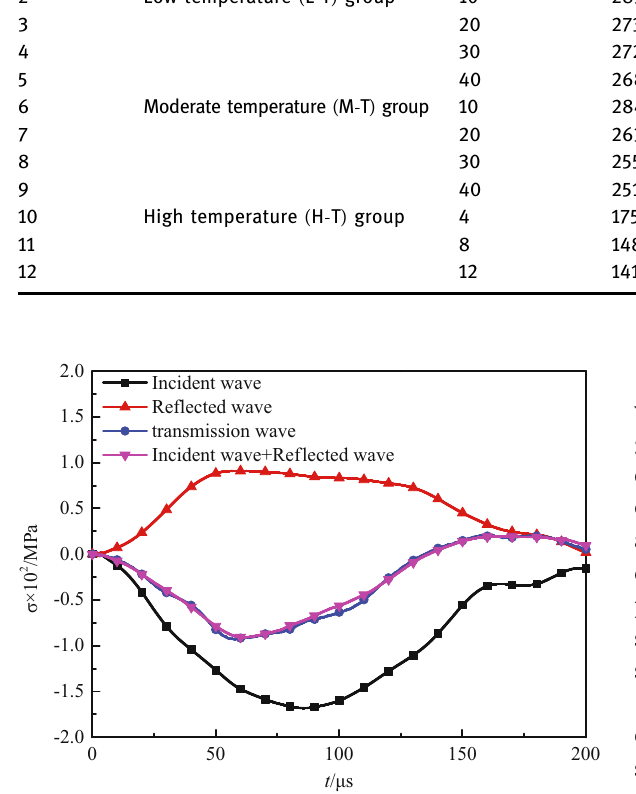
Figure 2: Stress equilibrium of sandstone specimen after H – C